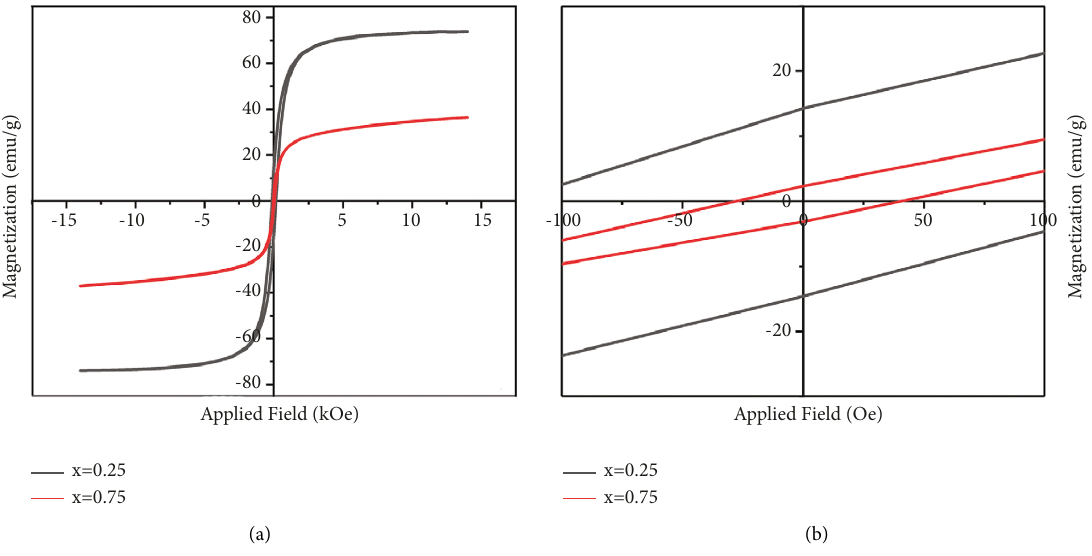
Figure 13: (a) Ni 1-x Zn x Fe 2 O 4 hysteresis loop at room temperature. (b) Expanded hysteresis